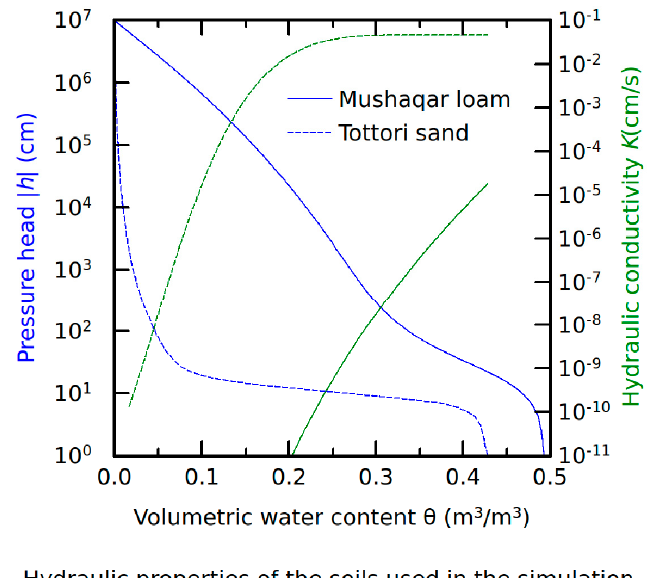
Figure 11. Hydraulic properties of soils used in the numerical simulation.